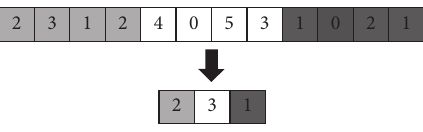
Figure 3: Process of mean pooling. Figure 4: Process of max pooling.